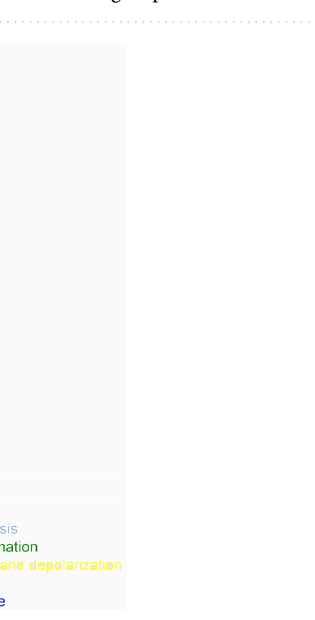
Figure 3. Molecular interaction network with 139 nodes consists of 125 proteins and 14 functions. The interaction numbers are 196 which are classified as two types: inhibiting (blue) and activating (red). Network consists of 95 detected proteins and some bridge nodes. Expressed proteins are clarified in 4 of 14 functions: Ca 2+ influx, apoptosis, inflammation and membrane